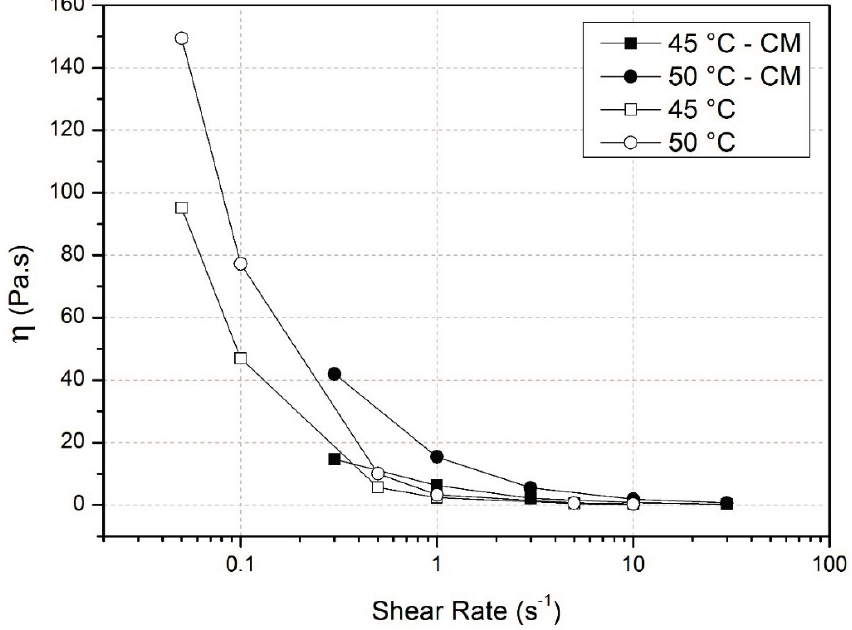
Figure 2. Comparison of viscosity obtained by Cox–Merz transformation (CM) and viscosity from steady-state experiments at 45 and 50 °C of methylcellulose A4M solution at 10